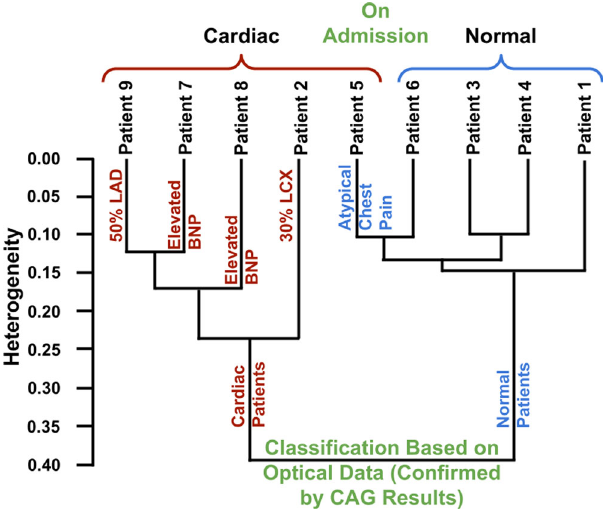
Fig. 3 Development of a transdermal kit. Heterogeneity dendrogram based on the hierarchical cluster analysis, indicating the classi fi cation of patients based on the noninvasively obtained transdermal optical cardiac protein data in conjunction with coronary angiogram results. (ROC = Receiver Operator Characteristics, AUC = Area Under Curve).